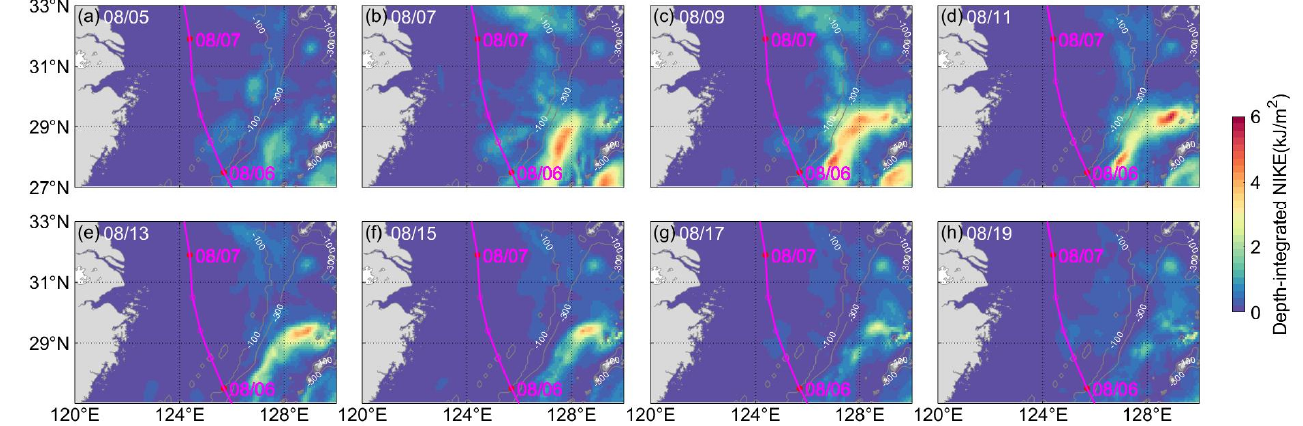
Figure 3. Depth-integrated NIKE at 00:00 on ( a ) 5, ( b ) 7, ( c ) 9, ( d ) 11, ( e ) 13, ( f ) 15, ( g ) 17 and ( h ) 19 August. In each subfigure, the magenta curve denotes the track of Muifa and the gray curves represent the 100 and 300 m isobaths.